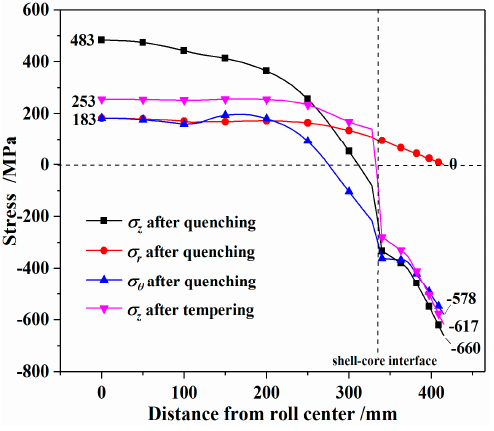
Figure 3. Residual stress distributions in the HSS work roll after heat treatment .